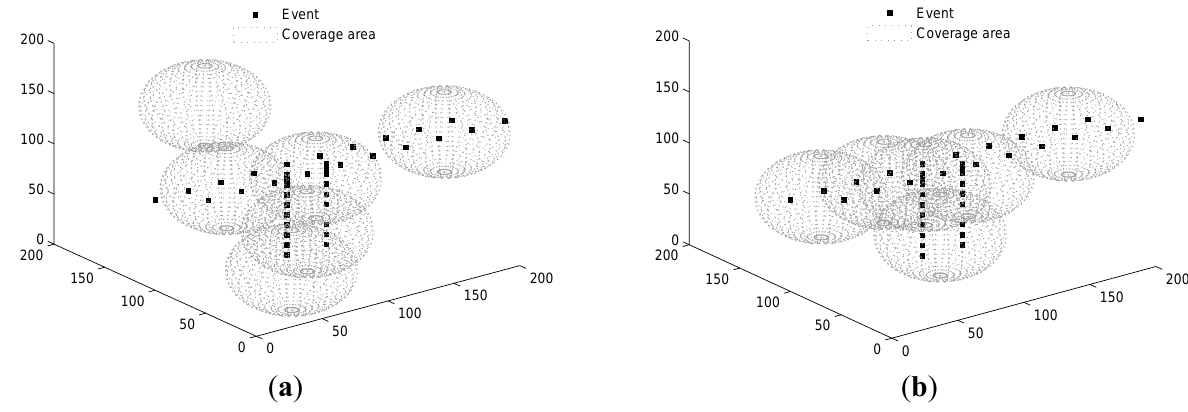
Figure 6. Events distributed non-uniformly along a line. ( a ) solution of SOM; ( b ) solution of PSSD.